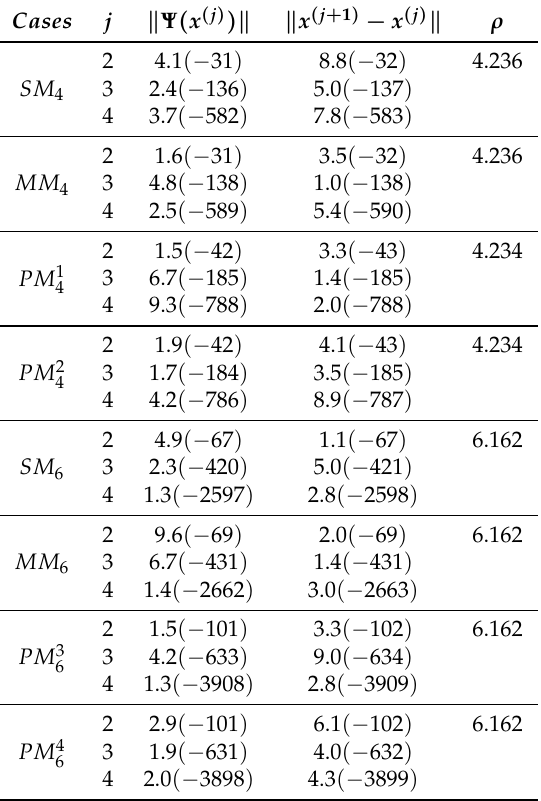
Table 5. Comparative study of different methods for Example